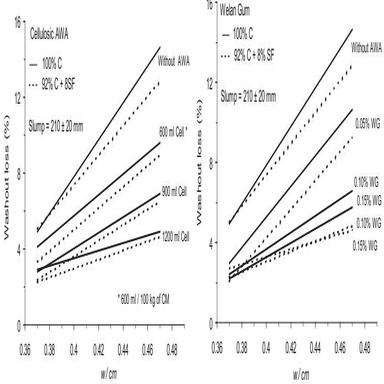
Effect of W/C and binder composition on variations of washout loss for mixtures made with different dosages of cellulosic AWA and 210 ± 20 mm slump. Reproduced from with permission.